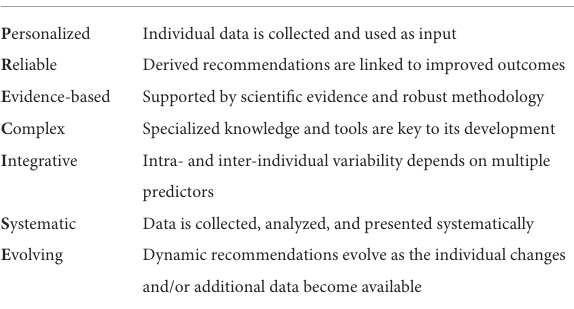
TABLE 1 Key attributes of precision